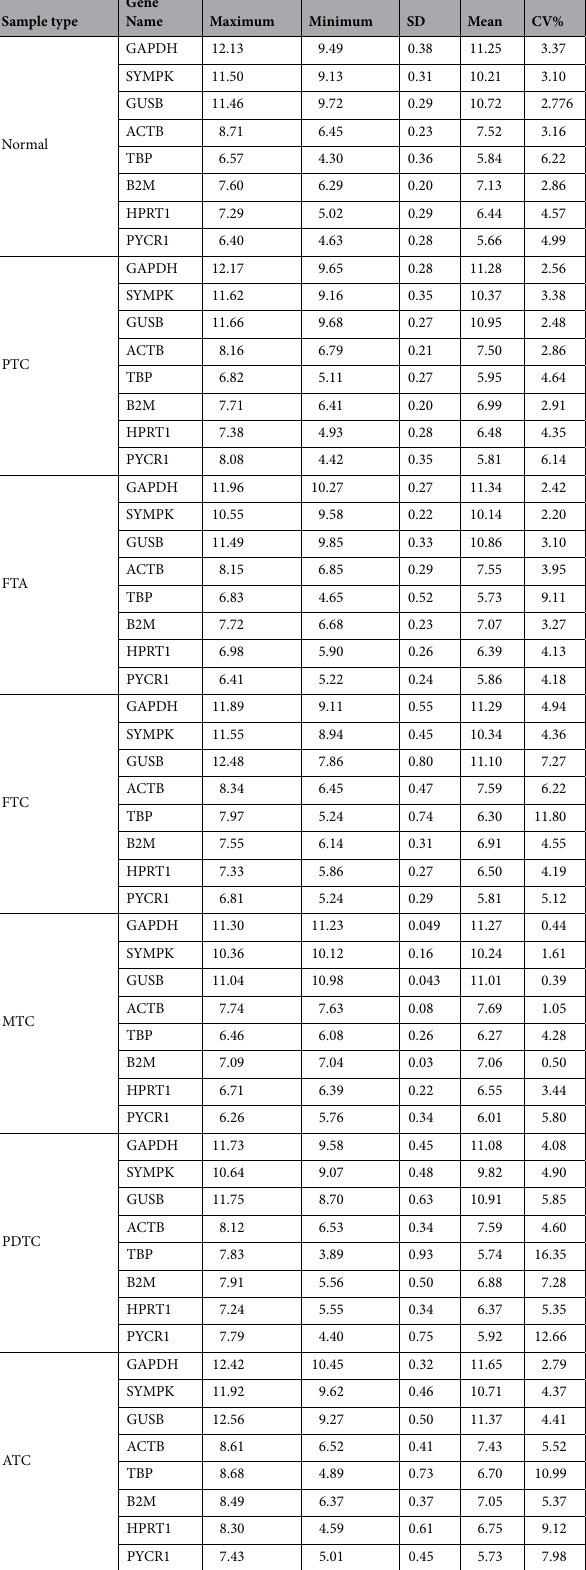
Table 7. GEO microarray dataset statistics for eight selected reference genes. Based on microarray datasets meta-analyses, statistics for eight reference genes were derived. B2M (0.20) in normal and PTC tissues,